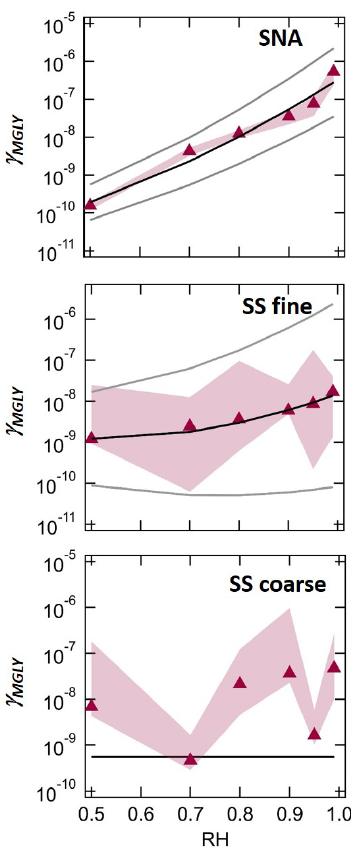
Figure 1. Calculated reactive uptake coefficients for uptake of gly- oxal to sulfate/nitrate/ammonium (SNA) aerosols, and fine and coarse sea salt (SS) aerosols, as defined in GEOS-Chem v11. Red shading indicates the uncertainty in γ GLYX . The black lines show the results of weighted least squares regression, with the confidence intervals in grey.